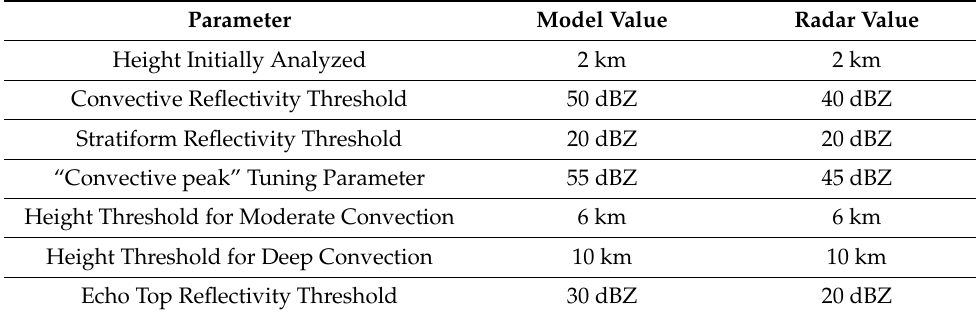
Table 2. Parameters for the Precipitation Partitioning